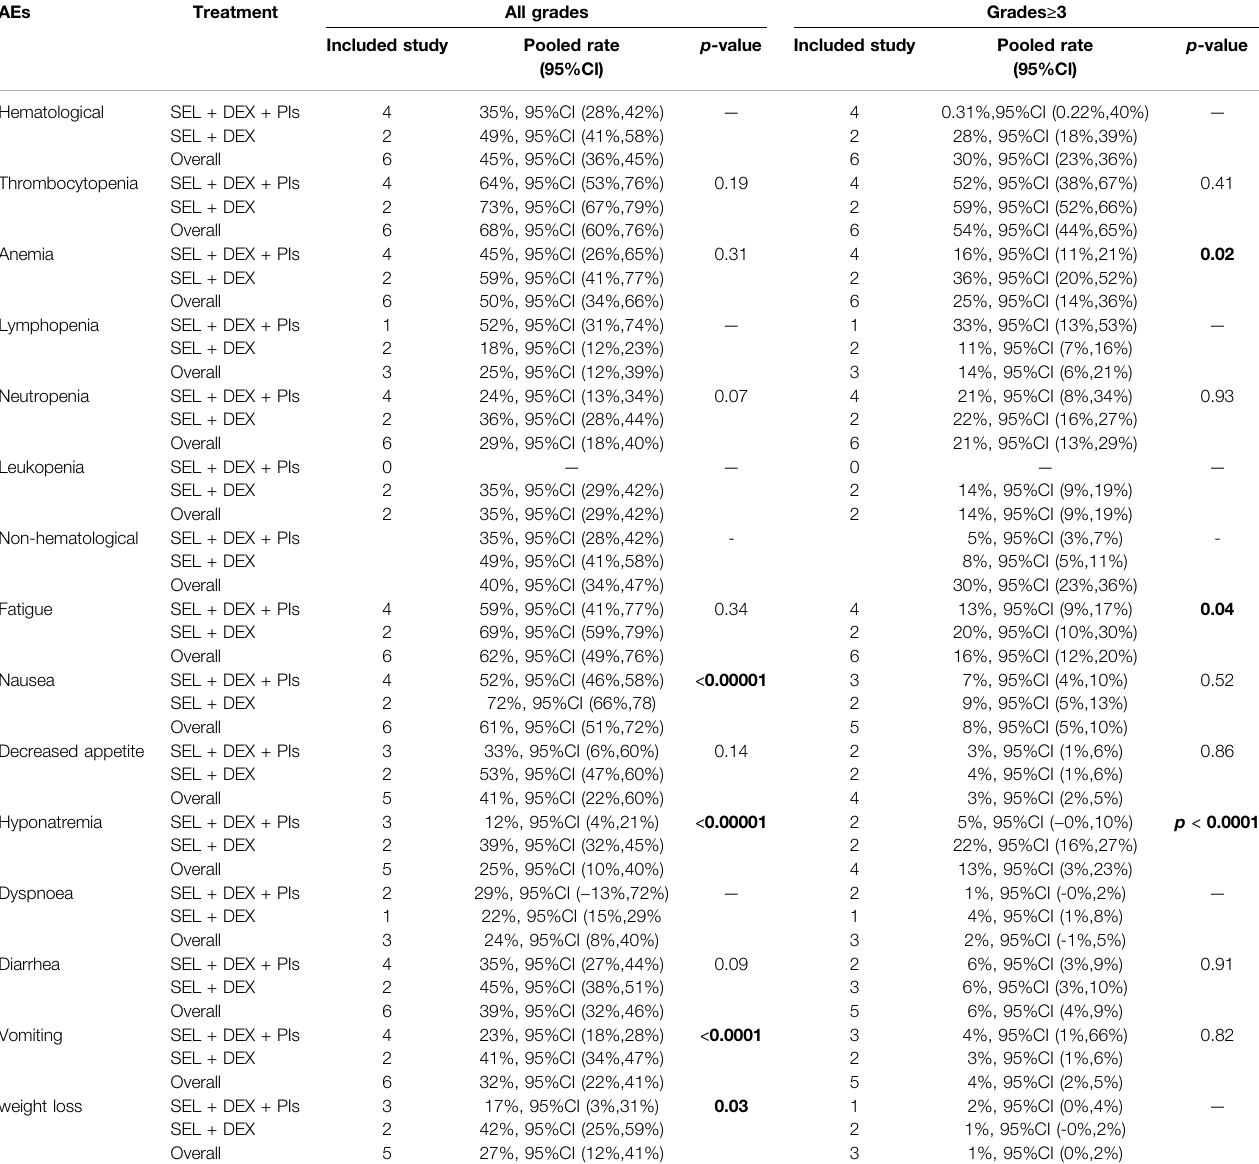
Bold values indicates the classi fi cation of the adverse